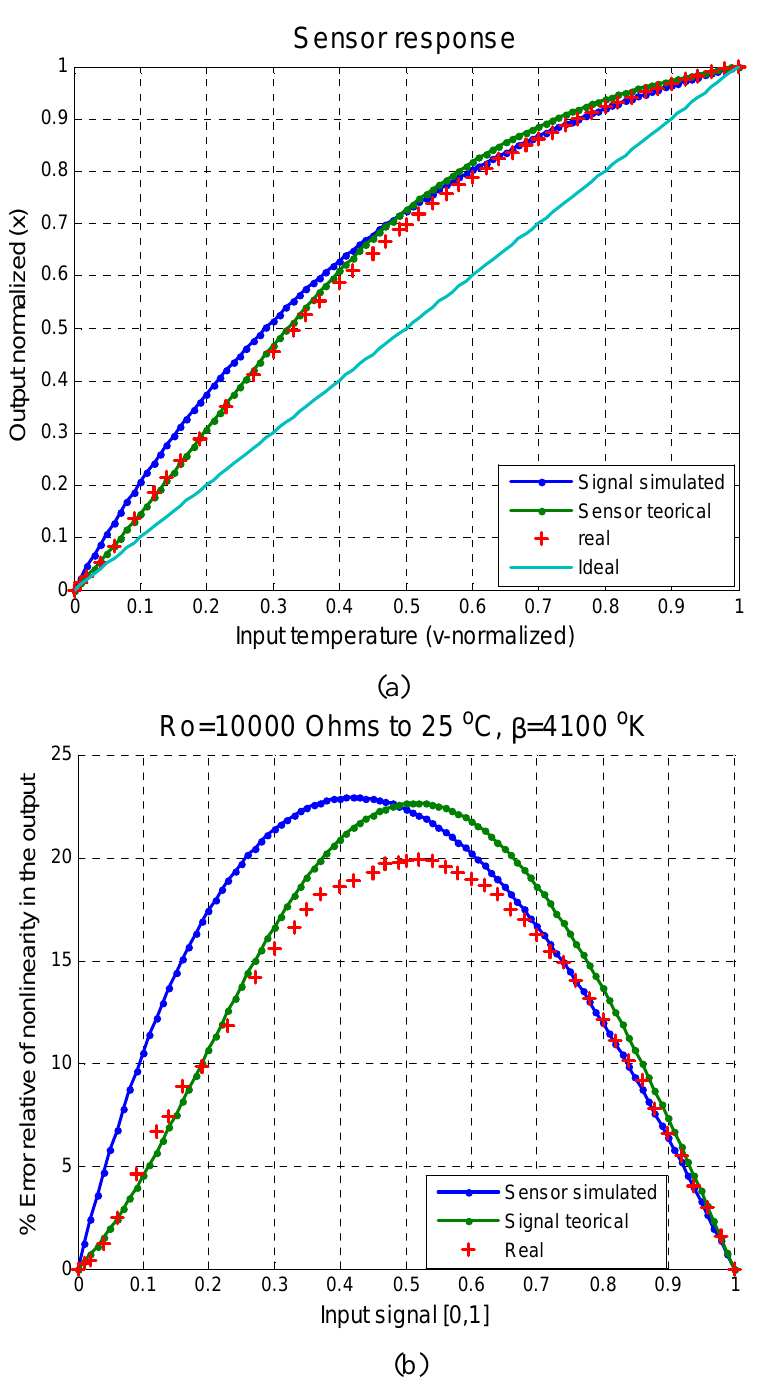
Figure 5. Characteristics of input signal x to the